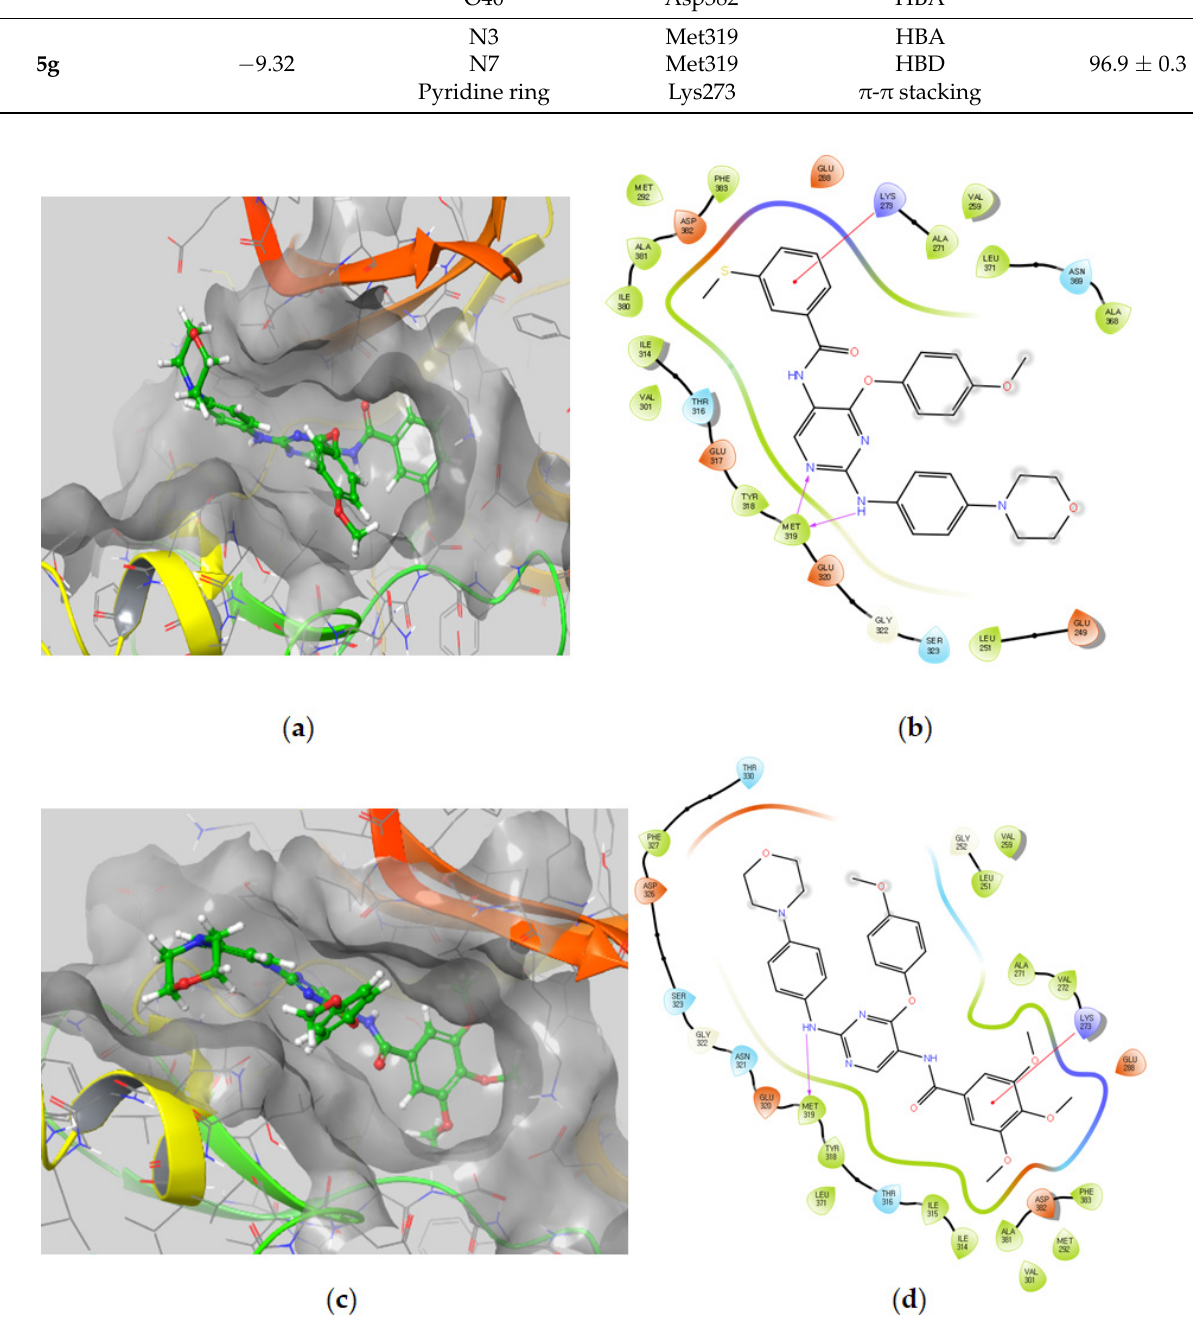
Figure 4. Docked complexes of compounds 5g and 5c with LCK. ( a , c ) 3D docking models of compounds 5g and 5c into LCK binding pocket, respectively. ( b , d ) 2D interaction diagrams of compounds 5g and 5c with LCK, respectively. Table 5. Computational analysis of all synthesized compounds against LCK.